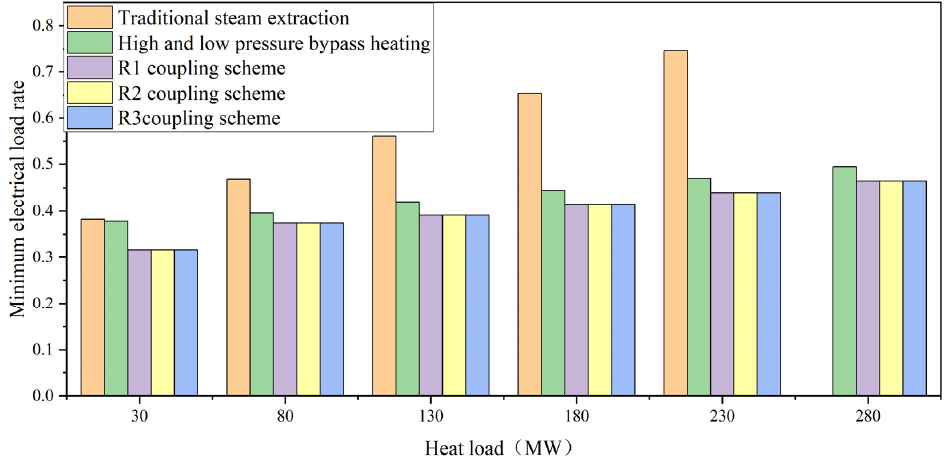
Figure 4. Comparison of the minimum charge rate.